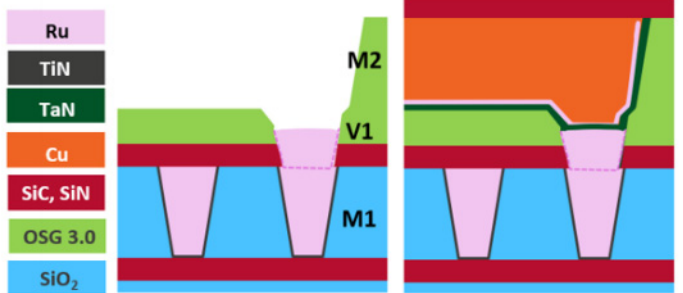
Figure 9. Schematic diagram of Cu hybrid metallization in a two-metal system: ( left ) Ru pre-fill on Ru followed by ( right ) barrier/liner Cu trench metallization. Reprinted/adapted with permission from Ref. [71]. 2020, IEEE.